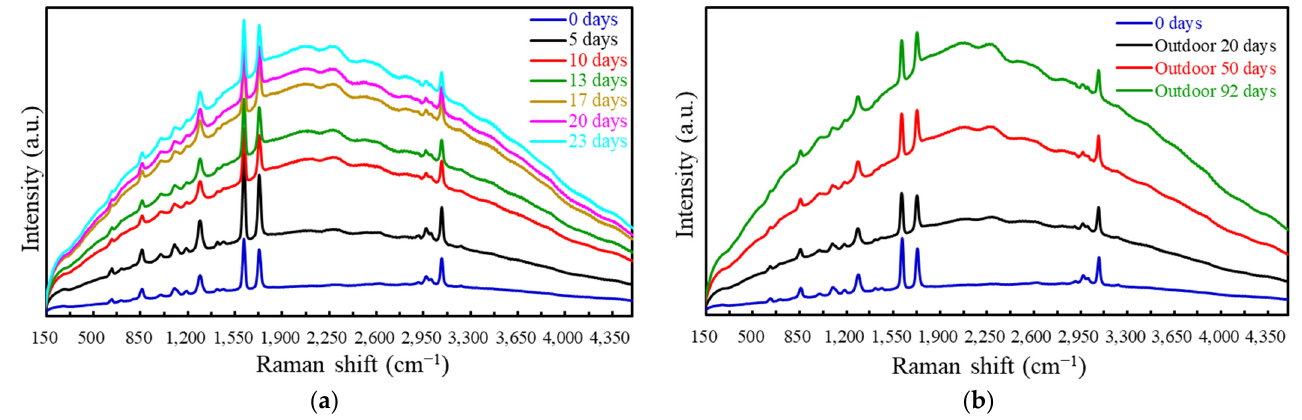
Figure 6. Raman spectra of OMO samples before and after the ( a ) indoor accelerated and ( b ) outdoor weathering tests.